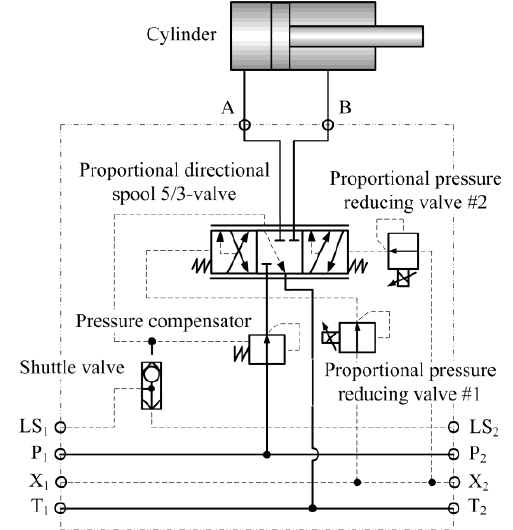
Figure 7. Conventional load sensing control block controls a cylinder.